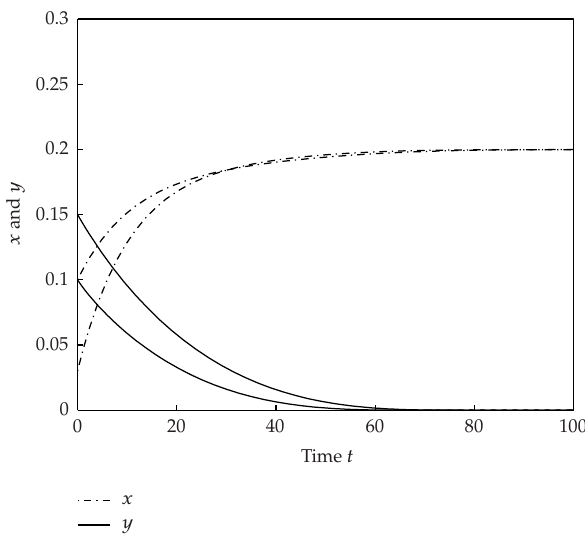
Figure 1: Solution curves for R 0 (cid:8) − 0 . 5 with initial value (cid:5) 0 . 03 , 0 . 1 (cid:6) , (cid:5) 0 . 1 , 0 . 15 (cid:6)